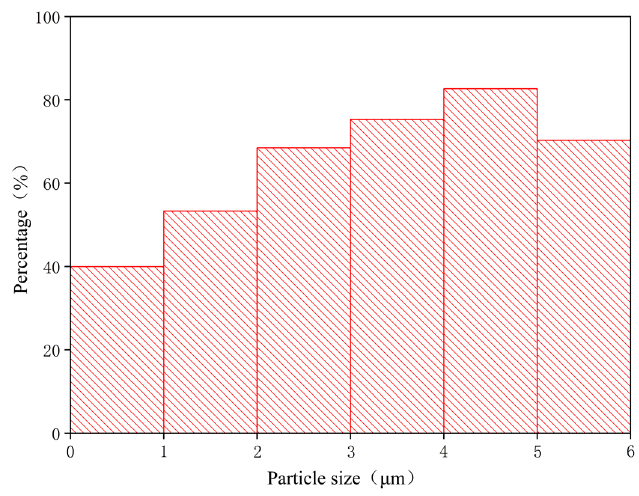
Figure 4. Particle size distribution of thermochromic microcapsules.